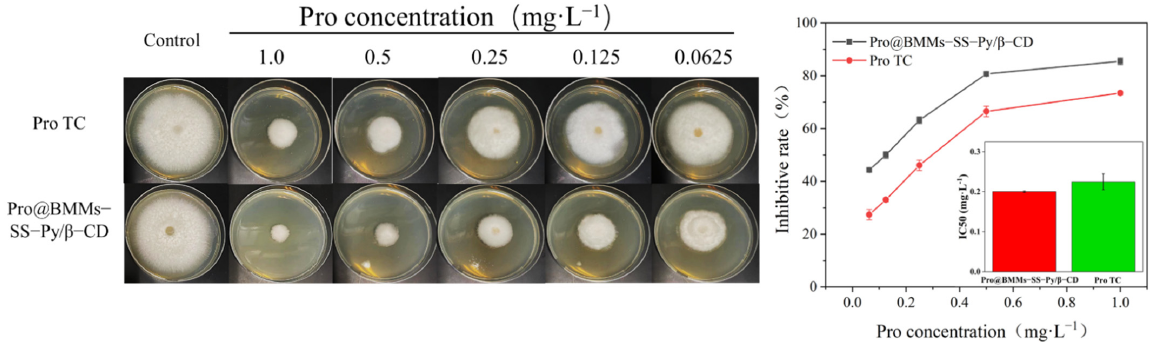
Figure 9. Fungicidal activity of Pro@BMMs − SS − Py/ β− CD NPs against R. solani .